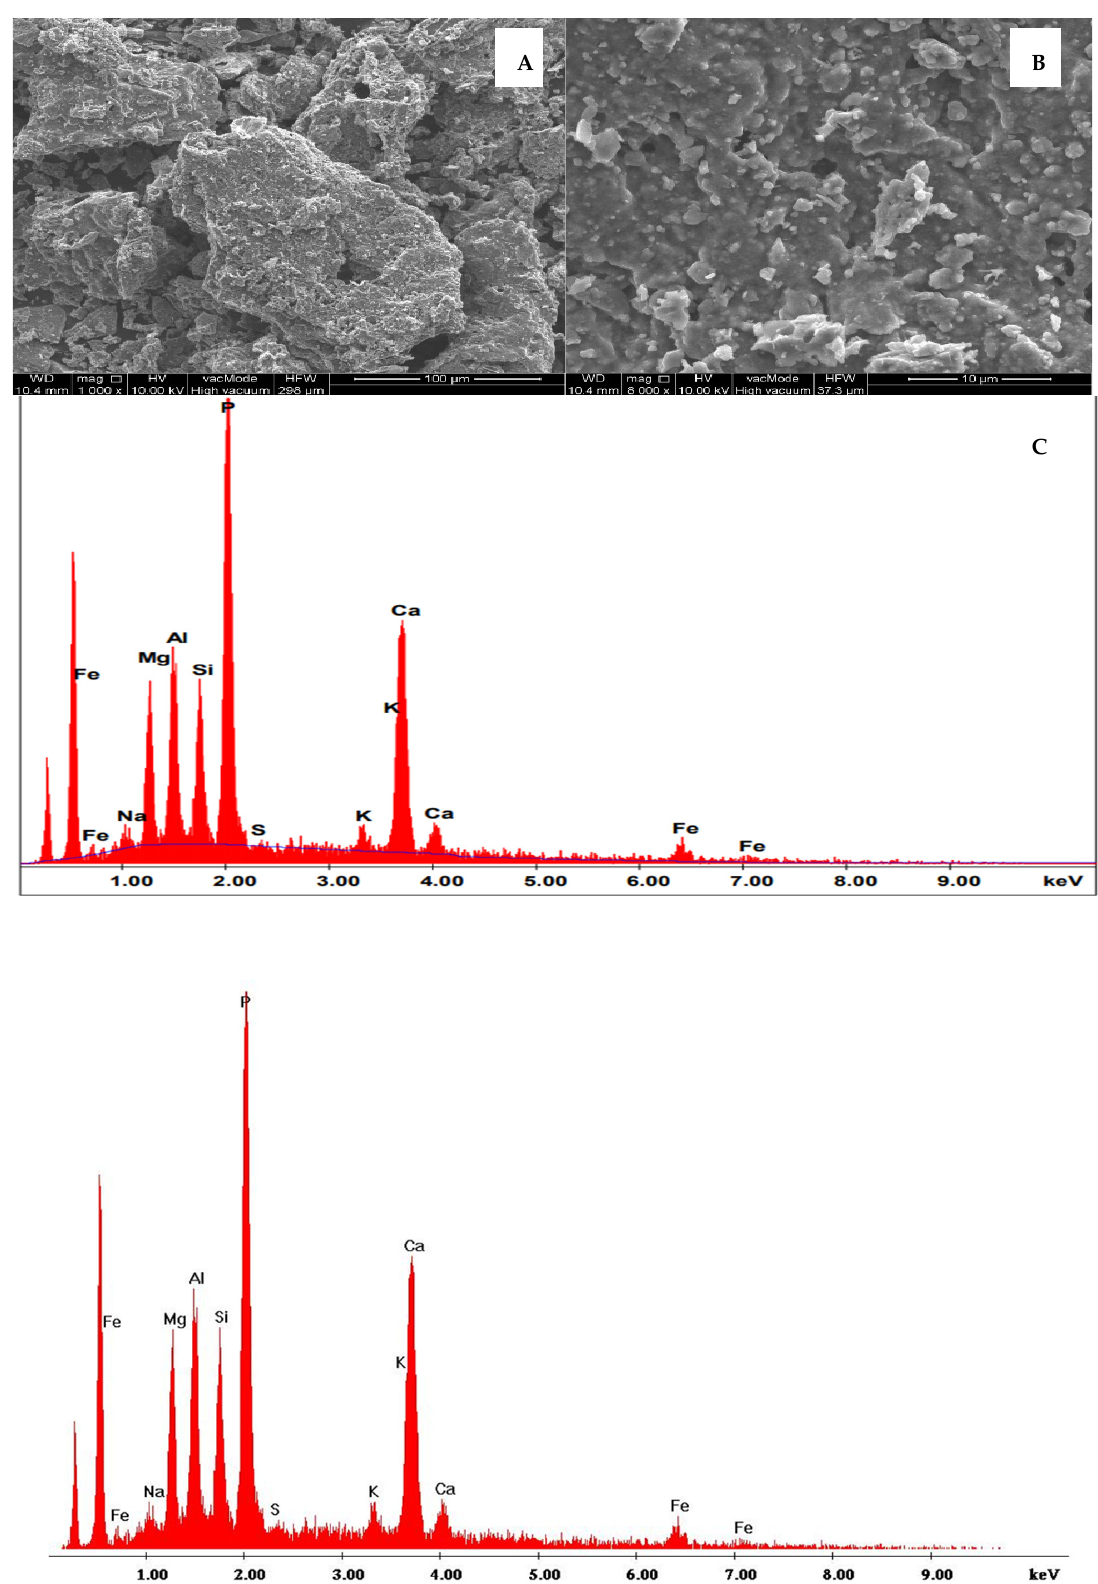
Figure 5. The SEM image of the researched ash from Kraków includes an EVS analysis: ( A ) ash microstructure; ( B ) ash microstructure; ( C ) the oxide composition of the ash.